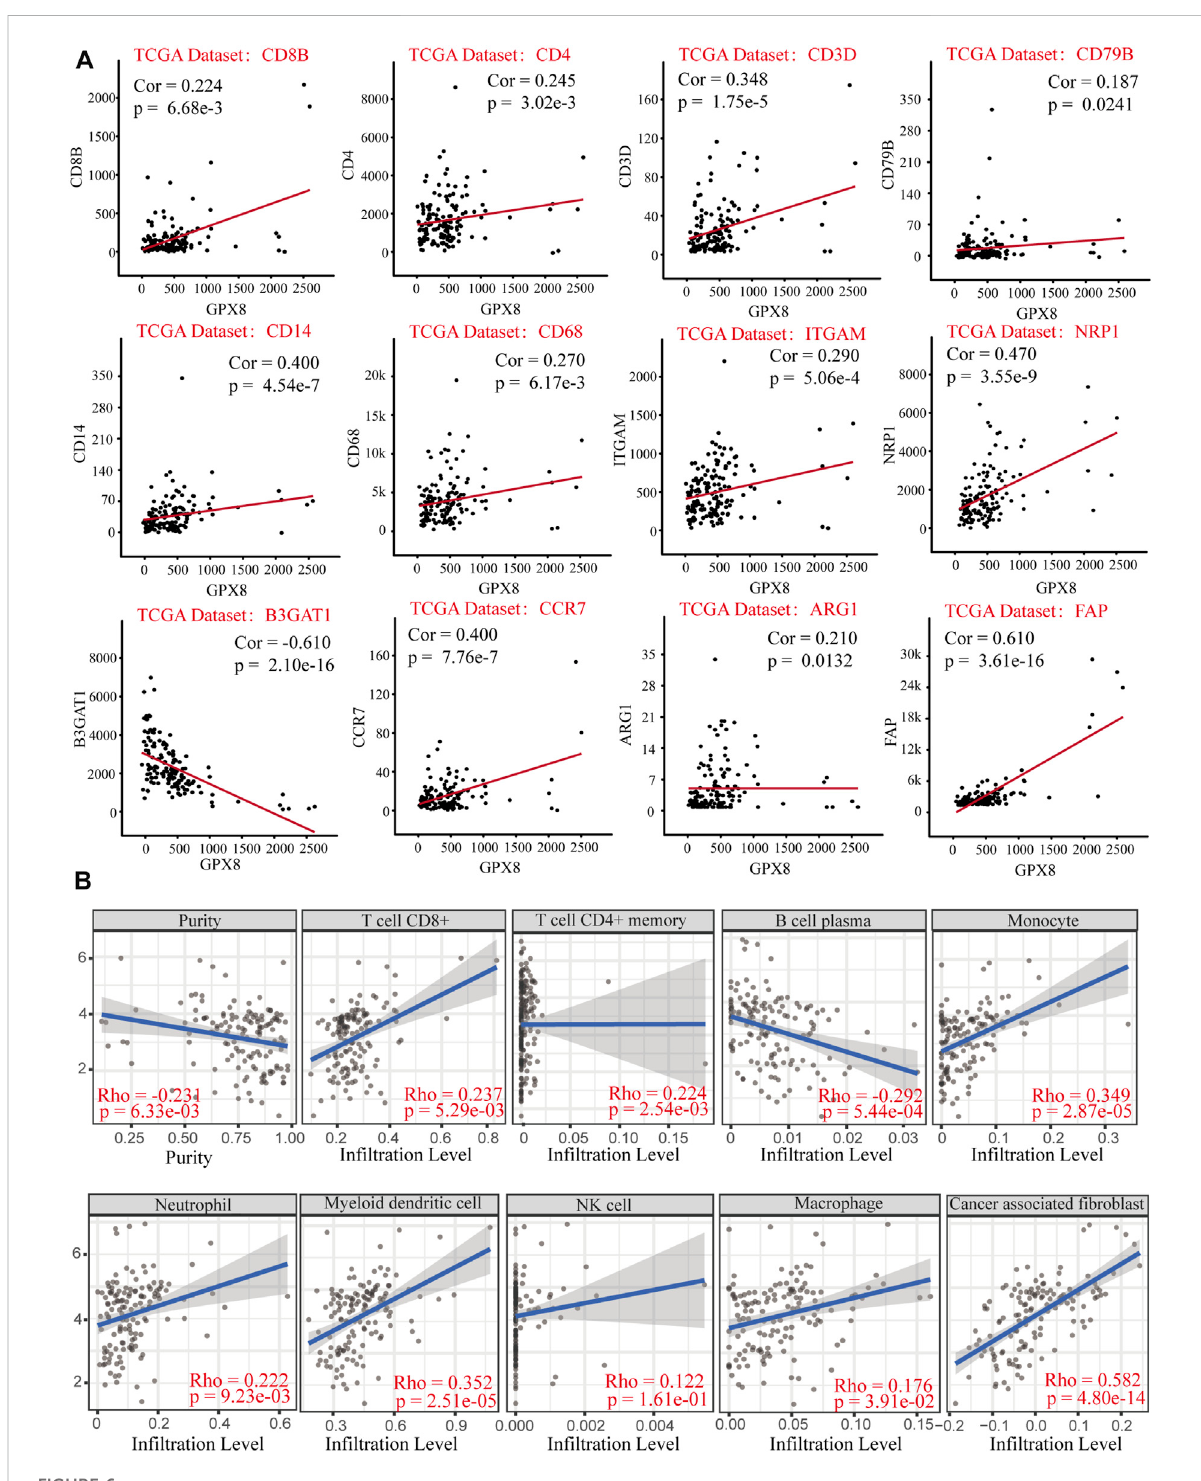
FIGURE 6 Correlation analysis of GPX8 mRNA expression with immune in fi ltration based on cBioPortal and TIMER2.0 databases. (A) Correlation between GPX8 and immune cell markers based on the cBioPortal database. (B) Correlation between GPX8 mRNA expression and immune cells in fi ltration accessing the TIMER2.0